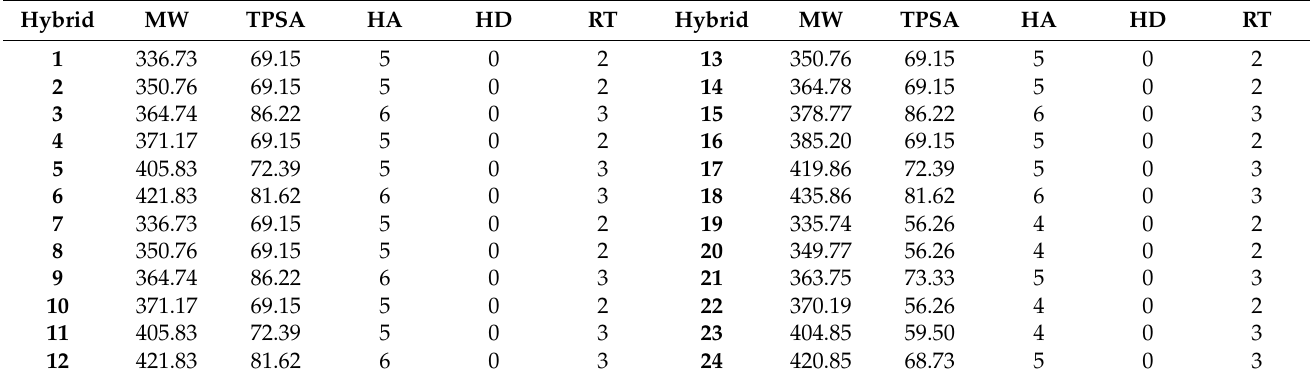
Table 6. The Lipinski and Veber descriptors of bioavailability.